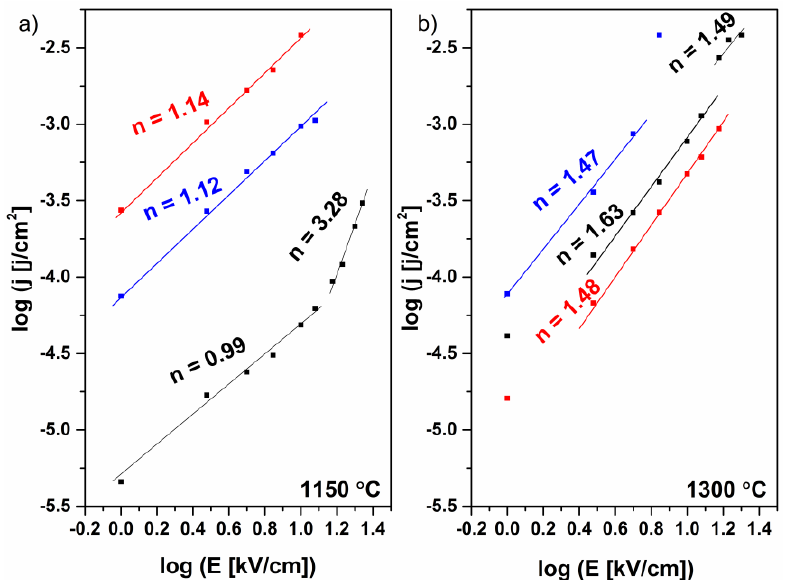
Figure 13. Leakage current measurements for the samples ( a ) sintered at 1150 ◦ C, ( b ) sintered at 1300 ◦ C (BaTiO 3 /NiFe 2 O 4 —black, BaTiO 3 /ZnFe 2 O 4 —blue, and BaTiO 3 /Ni 0.5 Zn 0.5 Fe 2 O 4 —red) as log j—log E dependence; n represents the slope of the curves in logarithmic plots.